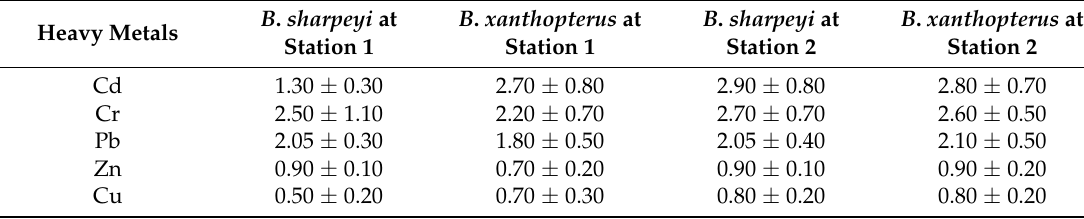
Table 2. Mean concentrations of heavy metals ( µ g/g) in the livers of B . sharpeyi and B . xanthopterus at Station 1 and Station